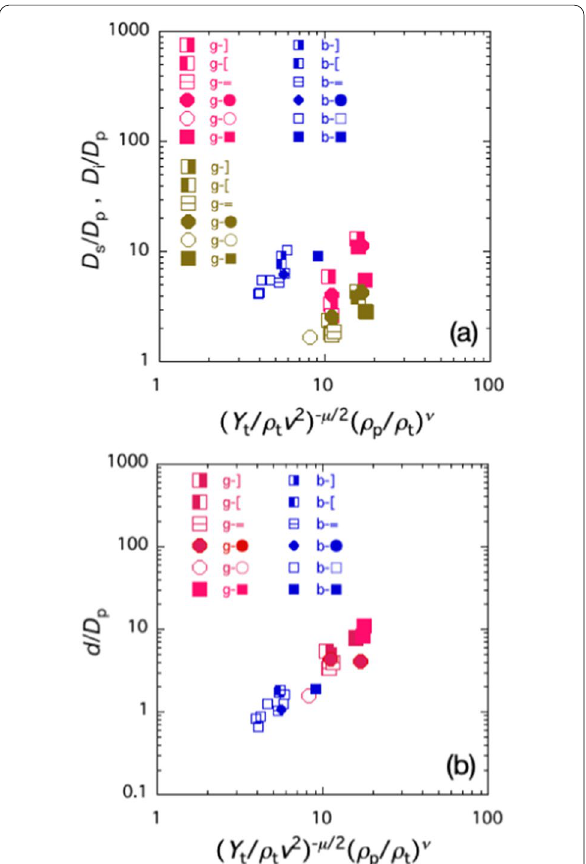
Fig. 4 a Surface diameter, D s , and inner diameter, D i , normalized by D p . b Crater depth, d , normalized by D p . In both panels, the horizontal axis is the same, π 3 − μ/2 π 4 − ν , where μ and ν are set to 0.55 and 0.4, respectively. The previous data of porous gypsum (Yasui et al. 2012) and basalt (Dohi et al. 2012) with nylon projectiles are also plotted. The symbols in the legend of each figure are as described for Fig. 3